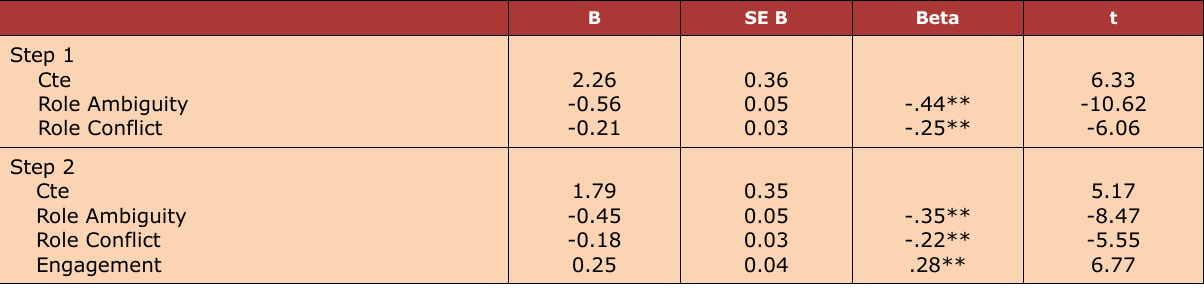
Table 2. Hierarchical regression results for job